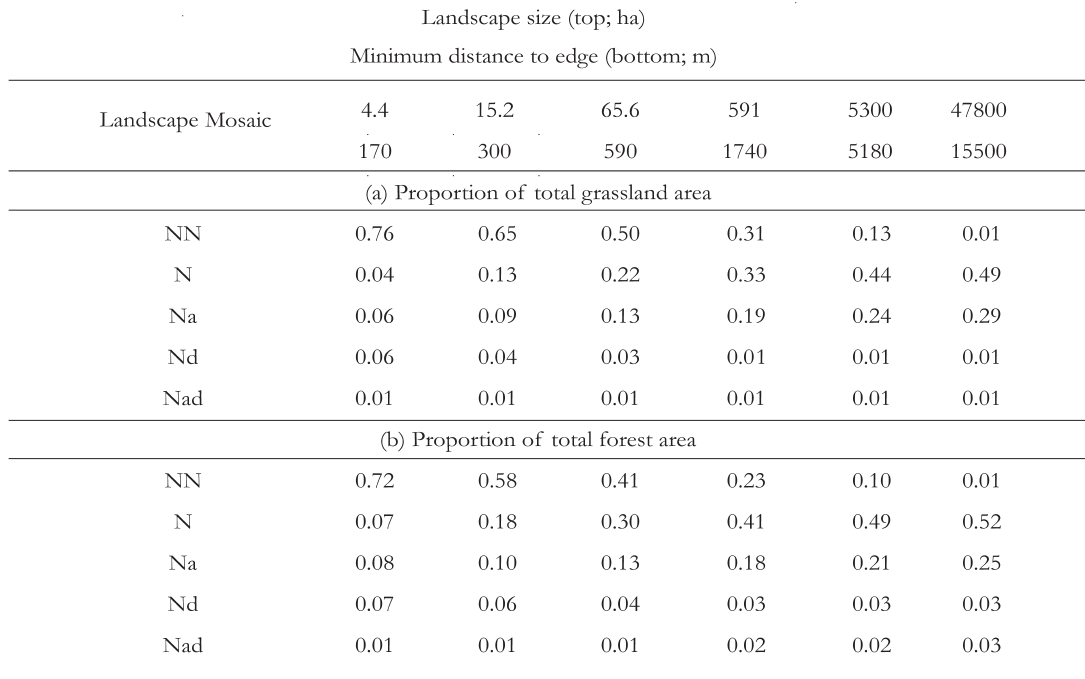
Table 2: The distribution of (a) total grassland area and (b) total forest area among landscape mosaics in natural landscape backgrounds, for six landscape sizes. Except for rounding errors, the sum over landscape mosaics for a given landscape size and land-cover type equals the value the for natural landscape background shown in